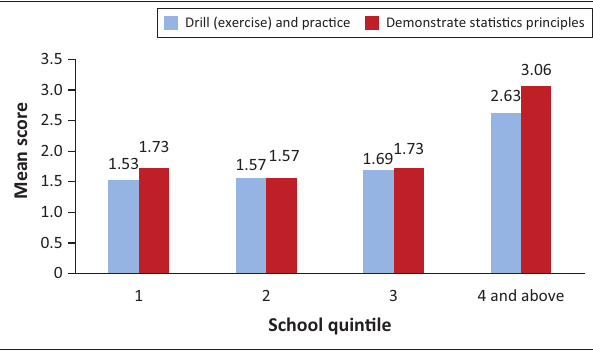
FIGURE 2: Using technology for instructional practice by school